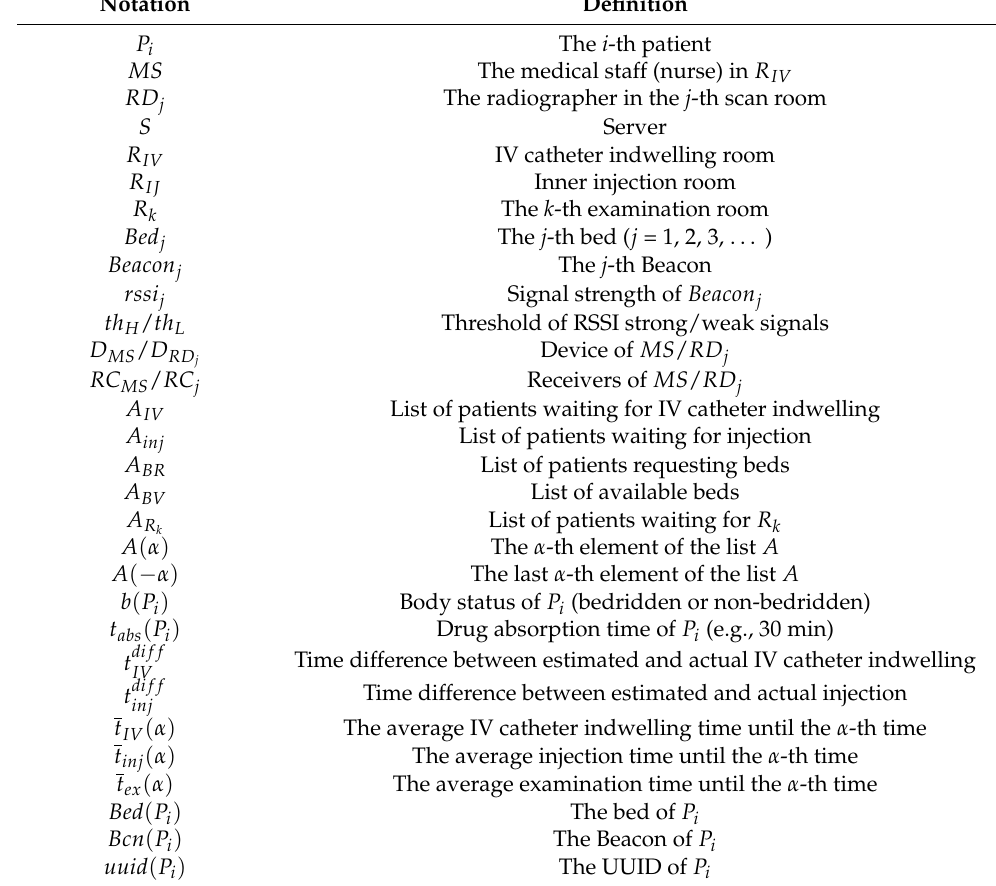
Table 1 defines the symbols and parameters used in the proposed method. The system is divided into seven phases and two algorithms: initial phase, patient check-in phase, patient indwelling needle phase, bed allocation phase, algorithm for scheduling examination room, estimating injection time and scan time, injection phase, scanning phase, end examination phase, and algorithm to determine Beacon’s entry and exit from a certain area.